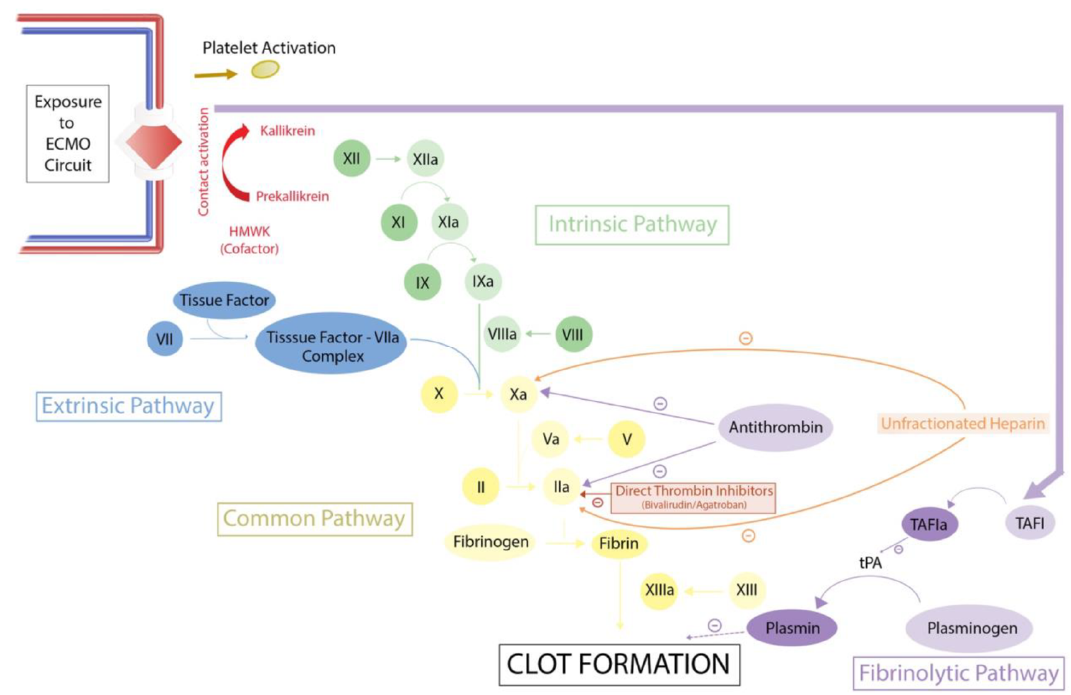
Figure 1. Coagulation & Fibrinolytic pathways.